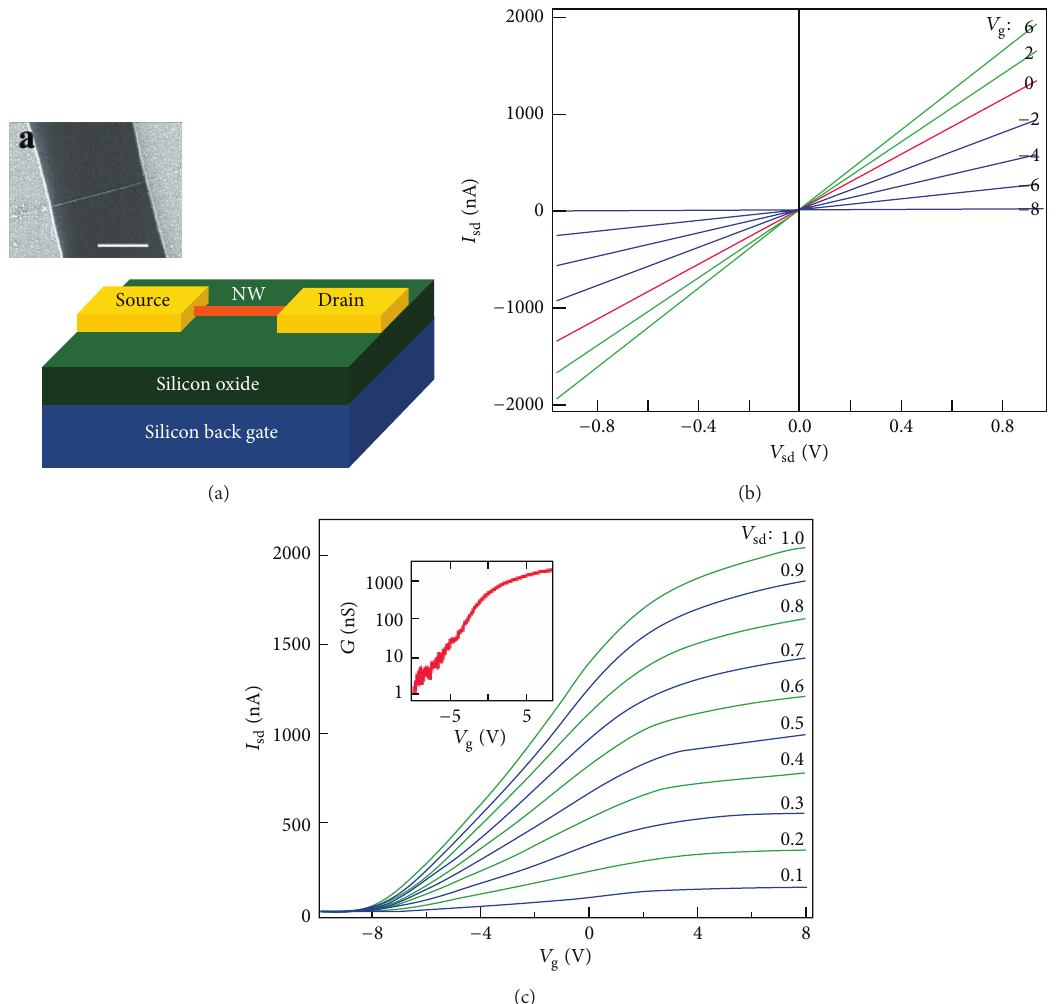
Figure 4: (a) Schematic of a NW FET and (inset) FE-SEM image of a GaN NW FET. (b) Gate-dependent 𝐼 - 𝑉 sd data recorded on a GaN NW. data recorded for values of 𝑉 sd ) 0.1–1 V. (inset) Conductance, 𝐺 , versus gate voltage. Reprinted with permission from [44]. Copyright (c) 𝐼 - 𝑉 g 2002 American Chemical